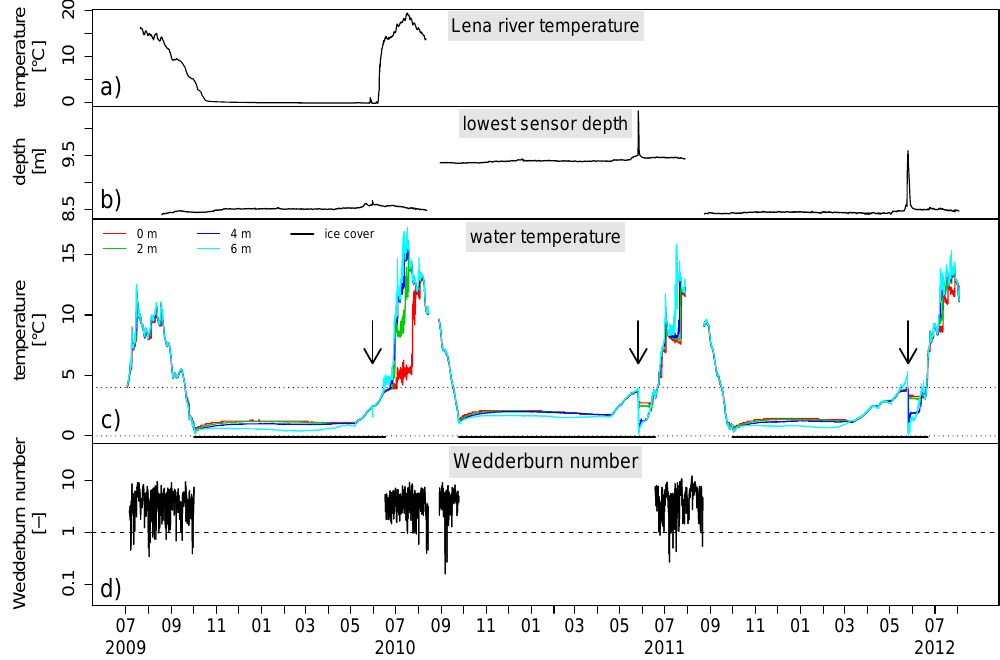
Figure 5. (a) Hourly temperatures for the Lena River from July 2009 to July 2010, and for Sa_Lake_4 (July 2009–August 2012): (b) depth of bottom sensor as indicator for water level changes: sharp increase in depth during May 2011 and 2012 indicates flooding with Lena River water; (c) water temperatures and ice cover duration; (d) Wedderburn number (dimensionless) calculated for the ice-free period. Arrows indicate the timing of the lake’s seasonal flooding by Lena river